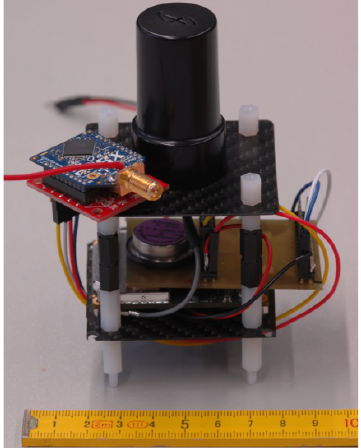
Figure 4. TOPCON dual frequency receiver